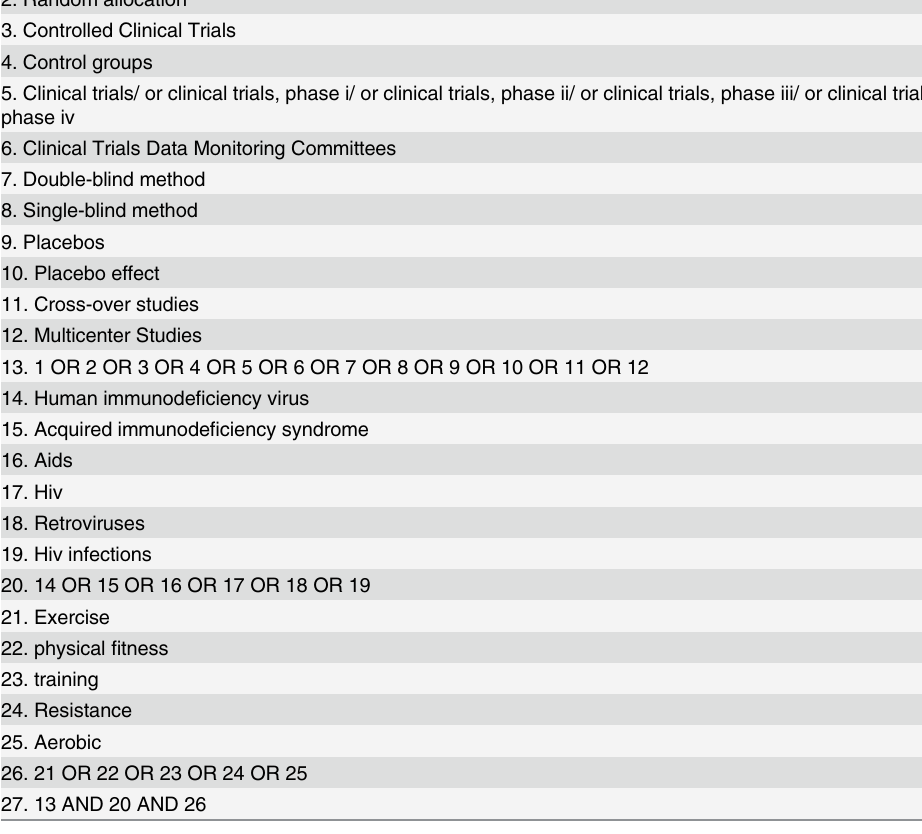
Table 1. Search strategy MEDLINE via